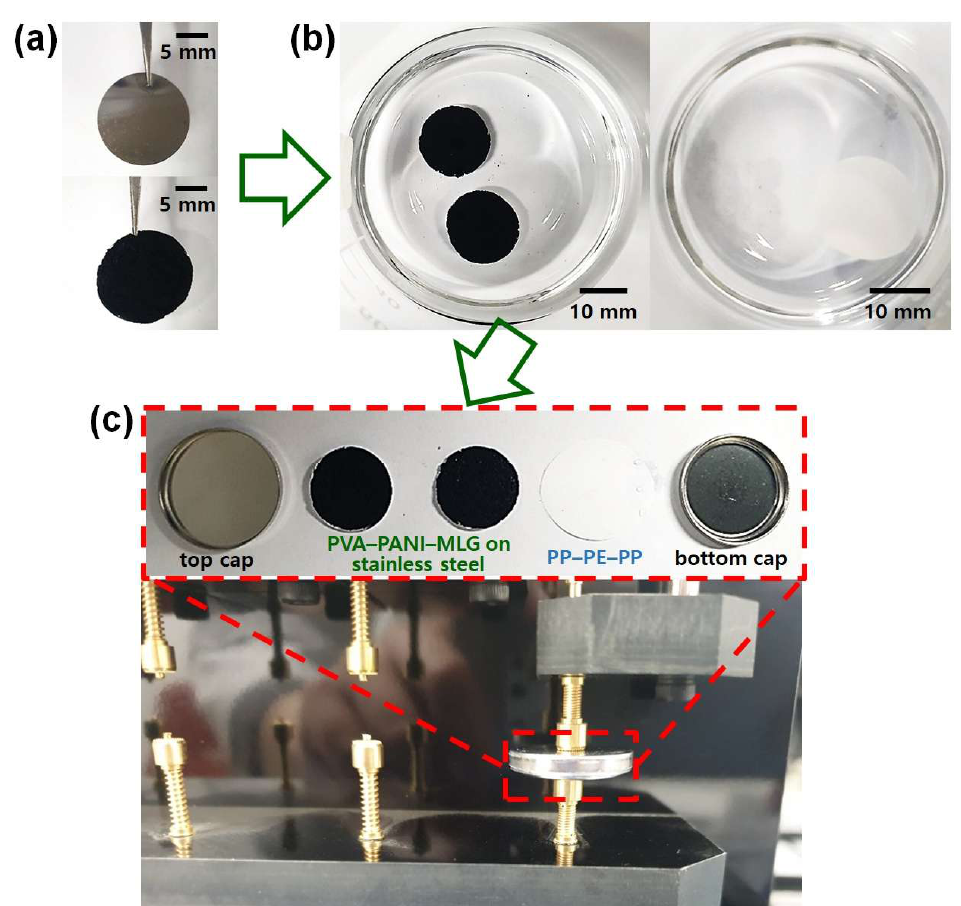
Figure 1. Overall procedures for electrode preparation and coin cell assembly steps: ( a ) digital